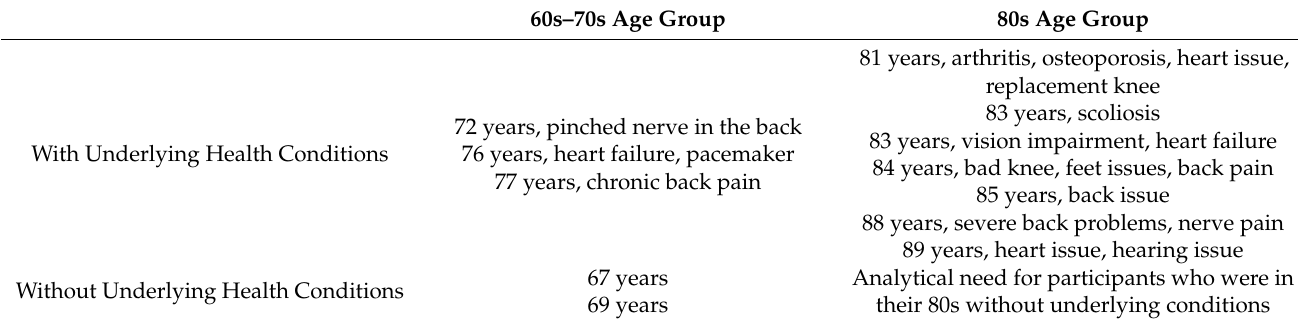
Table 1. Theoretical